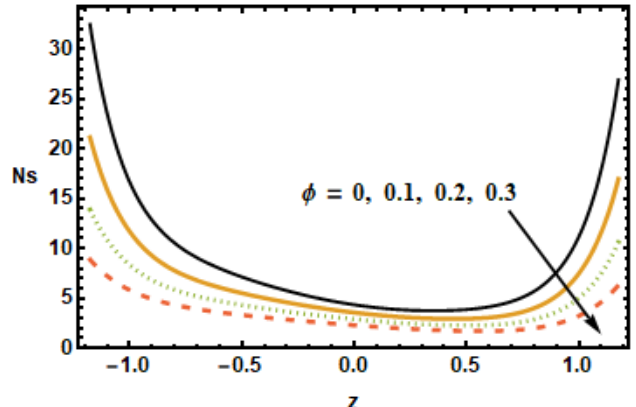
Figure 21. Effects of volume fraction φ on Ns